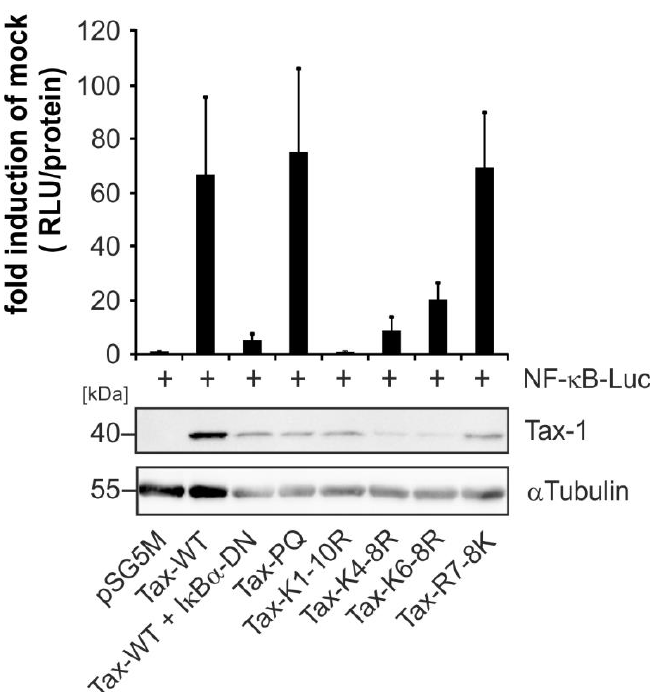
Figure A1. Tax point mutants differentially activate NF-κB signaling. The NF-κB reporter plasmid (NF-κB-Luc; 0.1 μg) was transfected together with Tax-1 wildtype (pSG-Tax-WT) or point mutants of Tax-1 (pSG-Tax-PQ, pSG-Tax-K1-10R, pSG-Tax-K4-8R, pSG-Tax-K6-8R, and pSG-TaxR7-8K; 0.01 μg each) in 293T cells. Co-transfection of the dominant-negative mutant IκBα (pIκBα-DN; 0.1 μg) and empty vector (pSG5M) served as negative controls. All transfection mixtures were replenished with pSG5M to 1 μg of total DNA. After 48 h, cells were lysed and analyzed via immunoblot (upper panel) and luciferase assay (lower panel). Relative light units (RLUs) were normalized on protein concentration and on cells co-transfected with pSG5M (mock). The mean values ± SE of four independent experiments, each performed in triplicate, are shown.